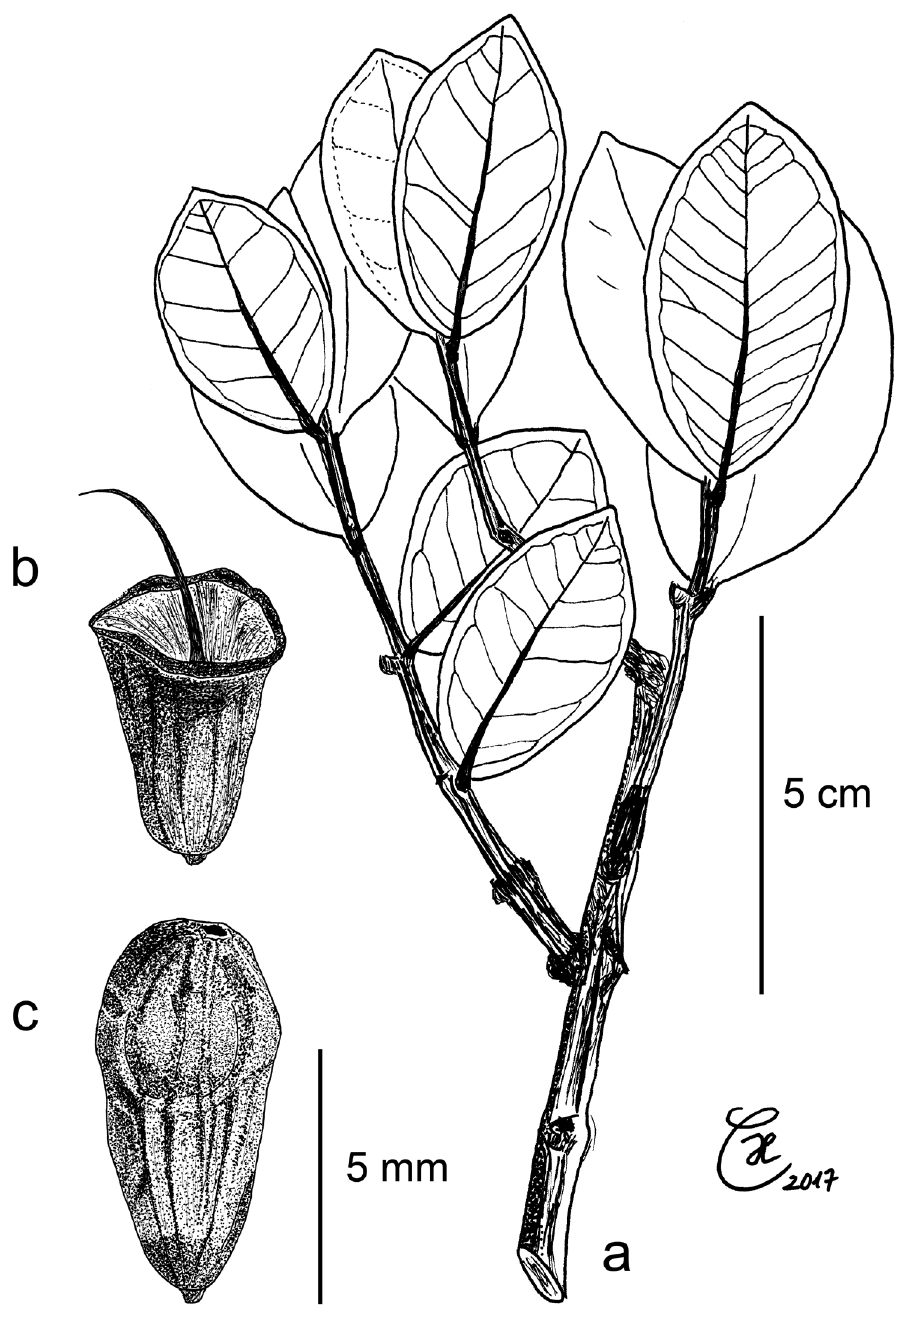
Figure 6. Syzygium eymae : a leafy twig b flower after shedding of calyx and stamens c closed pyriform flower, calyptrate calyx with minute apical opening. All drawings from isotype (L) Eyma